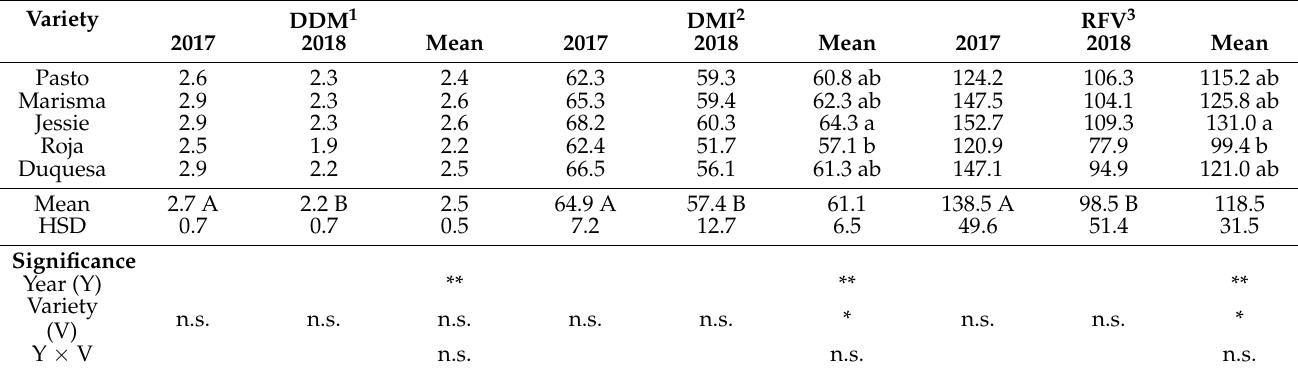
Table 4. Straw forage quality of five quinoa varieties during the two years (2017 and 2018) of field experiments. Variety DDM 1 DMI